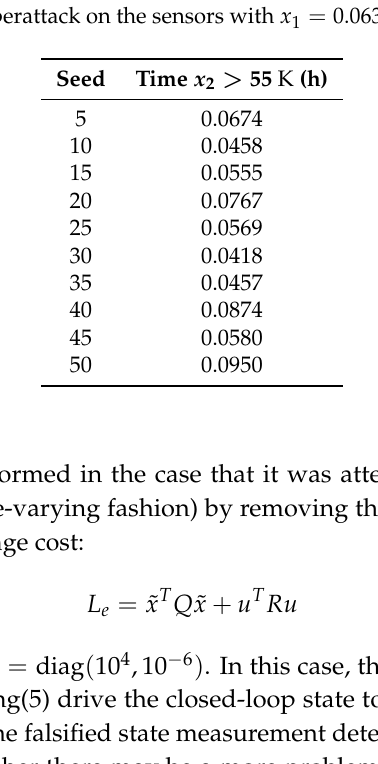
Figure 12. Trajectories of u 1 , u 2 , and V 1 under the randomized LMPC implementation strategy for rng(20) (denoted by ‘Randomized’ in the figure) and under the single LMPC (denoted by ‘Single’ in the figure). The value of ρ 1 is denoted by the horizontal line in the plot for the value of V 1 . The bottom plot indicates the controller selected by the randomized LMPC implementation strategy at each of the 10 sampling times in the simulation. Table 5. Approximate time after which x 2 > 55 K for various seed values of rng for the randomized LMPC design subjected to a cyberattack on the sensors with x 1 = 0.0632 kmol/m 3 and x 2 = 21.2056